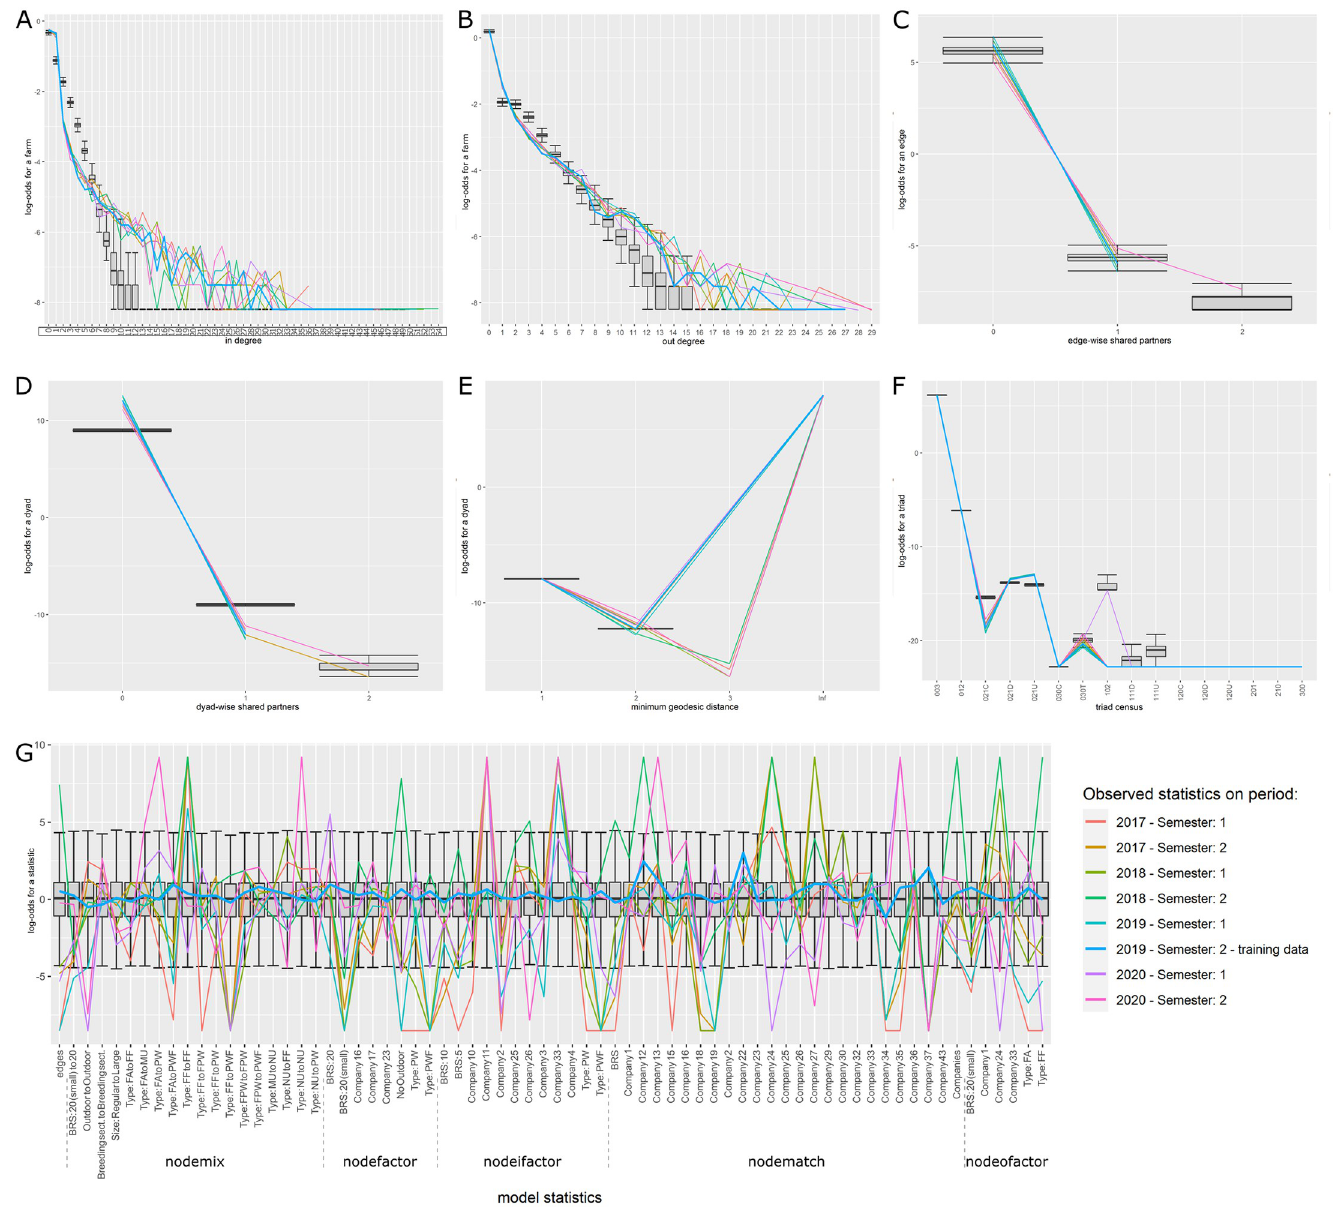
Fig 6. Goodness of fit of the piglets model. Goodness of fit of the model adjusted for the transport of piglets. Metrics of 5000 simulated networks (boxplot) are compared to metrics of observed semestrial network. Data of the second semester of 2019 were used for model fit (thick blue line). Colors correspond to different semesters’ networks. Details of the network metrics: A: indegree distribution, B: outdegree distribution, C: edgewise shared partners distribution, D: dyadwise shared partners distribution, E: minimum geodesic distance distribution, F: triads census, G: performance of the final model on in-model statistics.